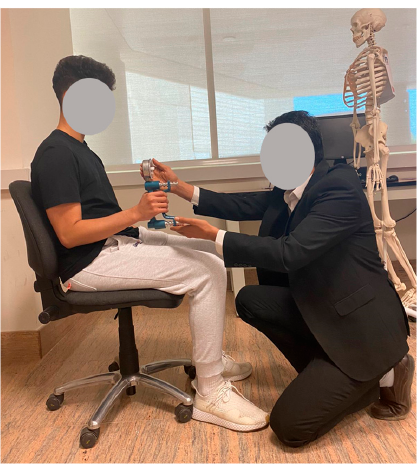
Figure 2. Illustration of the position for the measurement of Grip Strength.